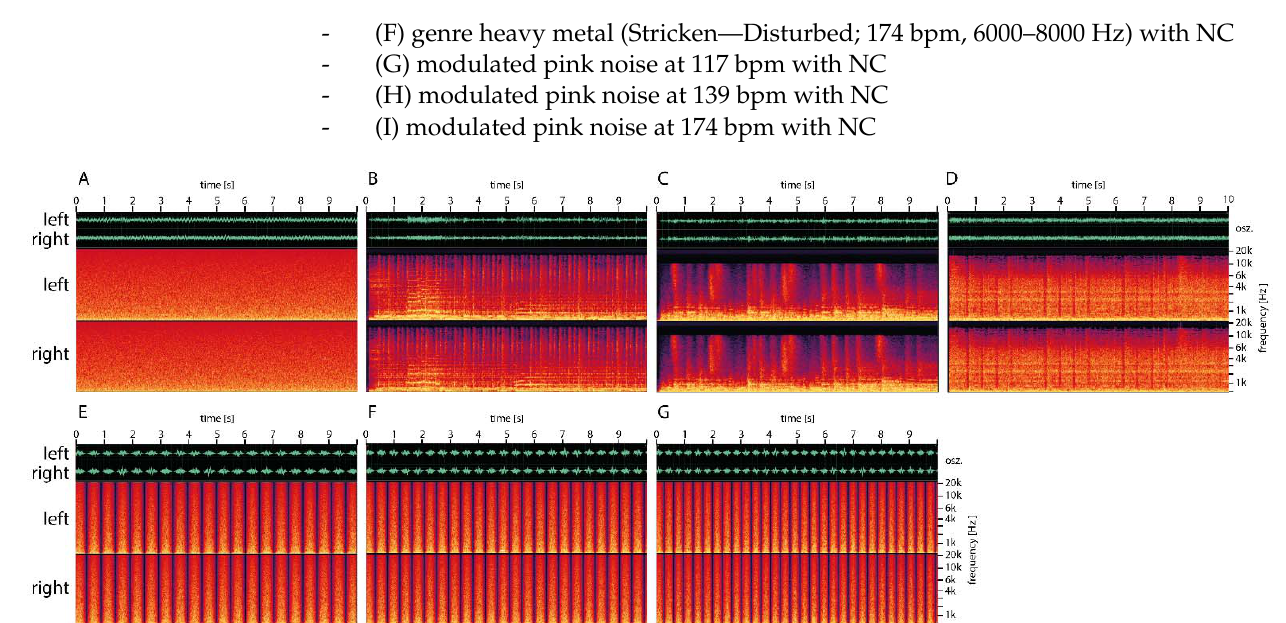
Figure 1. Oscillograph curves and spectral frequency representations for the first ten seconds of the sound stimuli used in the measurement conditions for both audio stereo channels. ( A ) pink noise, ( B ) relaxation music, ( C ) classical music, ( D ) heavy metal music, ( E ) modulated pink noise at 117 bpm, ( F ) modulated pink noise at 139 bpm, ( G ) modulated pink noise at 174 bpm.